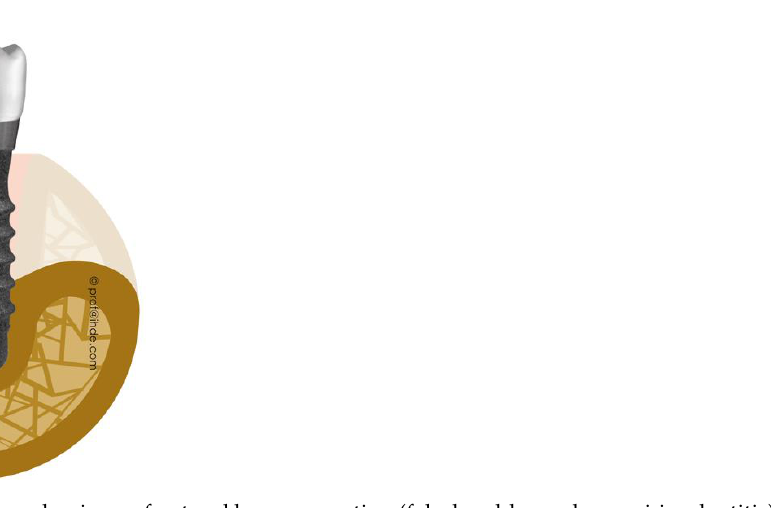
Figure 4. Due to the mechanisms of natural bone resorption (falsely addressed as peri-implantitis), the crestal angles created by the outer cortical layer of the bone and the vertical cortical layer (see Figure 3) are resolved. After the bone has arranged this acceptable morphology and after angles are flattened, no further bone loss is required.